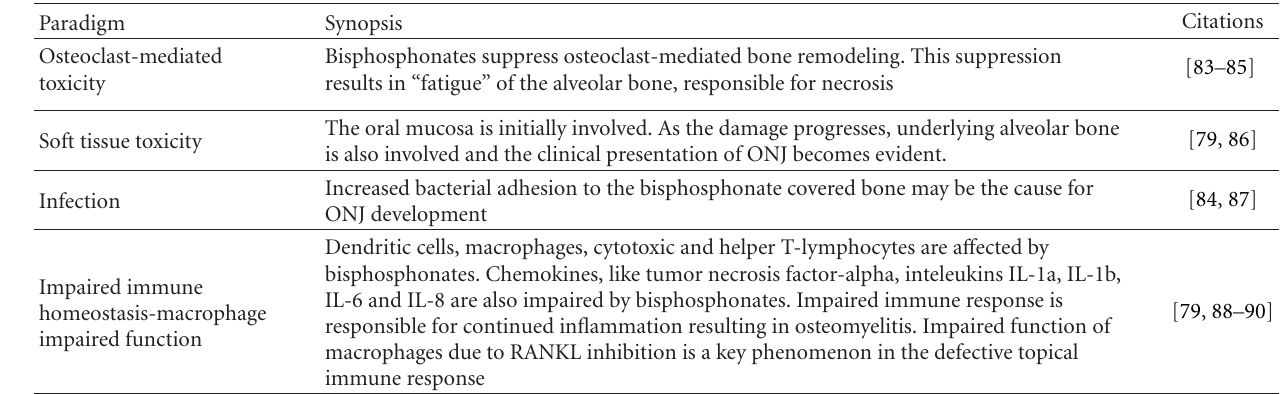
Table 2: Most plausible aetipathogenetic paradigms for osteonecrosis of the jaws